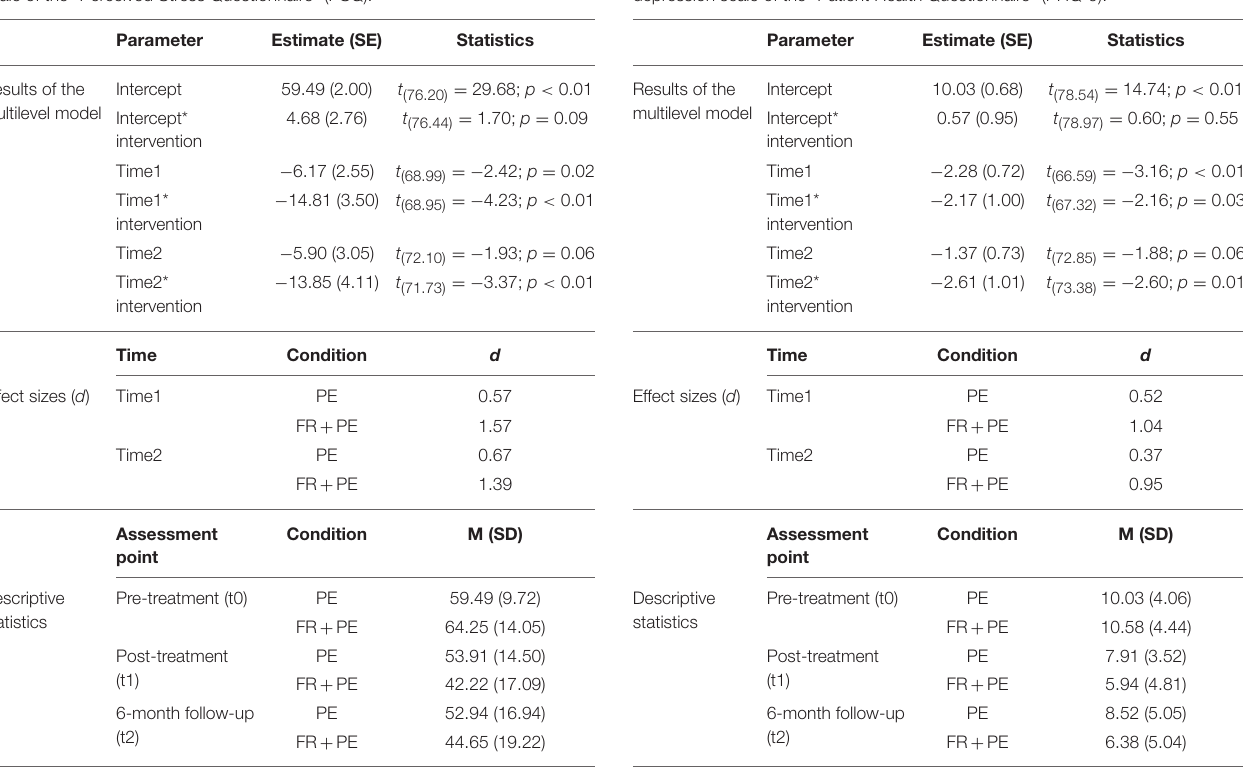
(secondary outcomes) as dependent variable. FR + PE and PE were comparable on these two PHQ scales at t0 (insignificant “intercept ∗ intervention” terms; both p > 0.05). PE significantly reduced depression from t0 to t1 (negative and significant